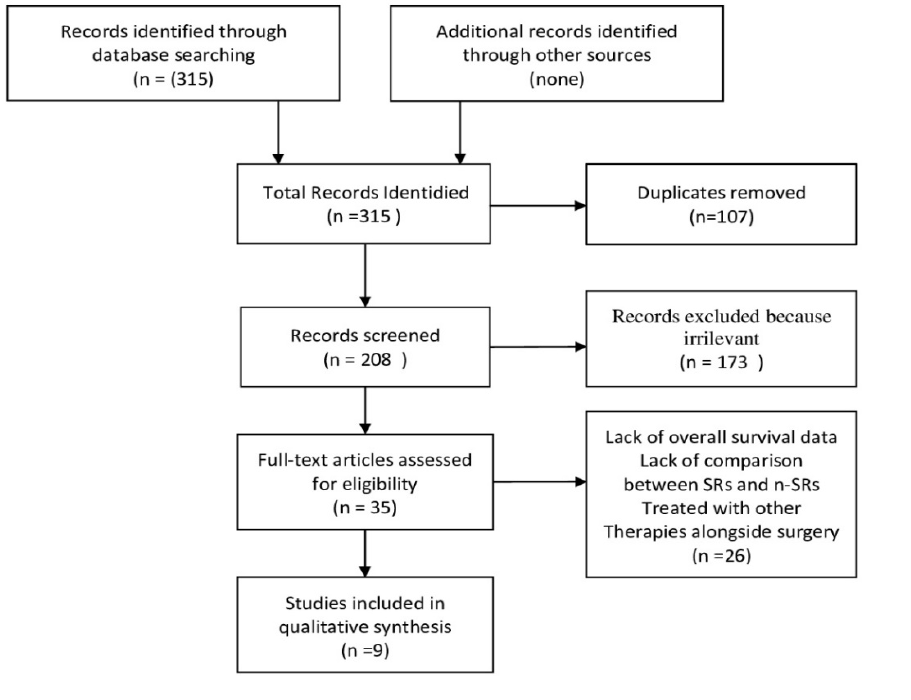
Figure 4. PRISMA flowchart. Table 1. Characteristics of the studies.